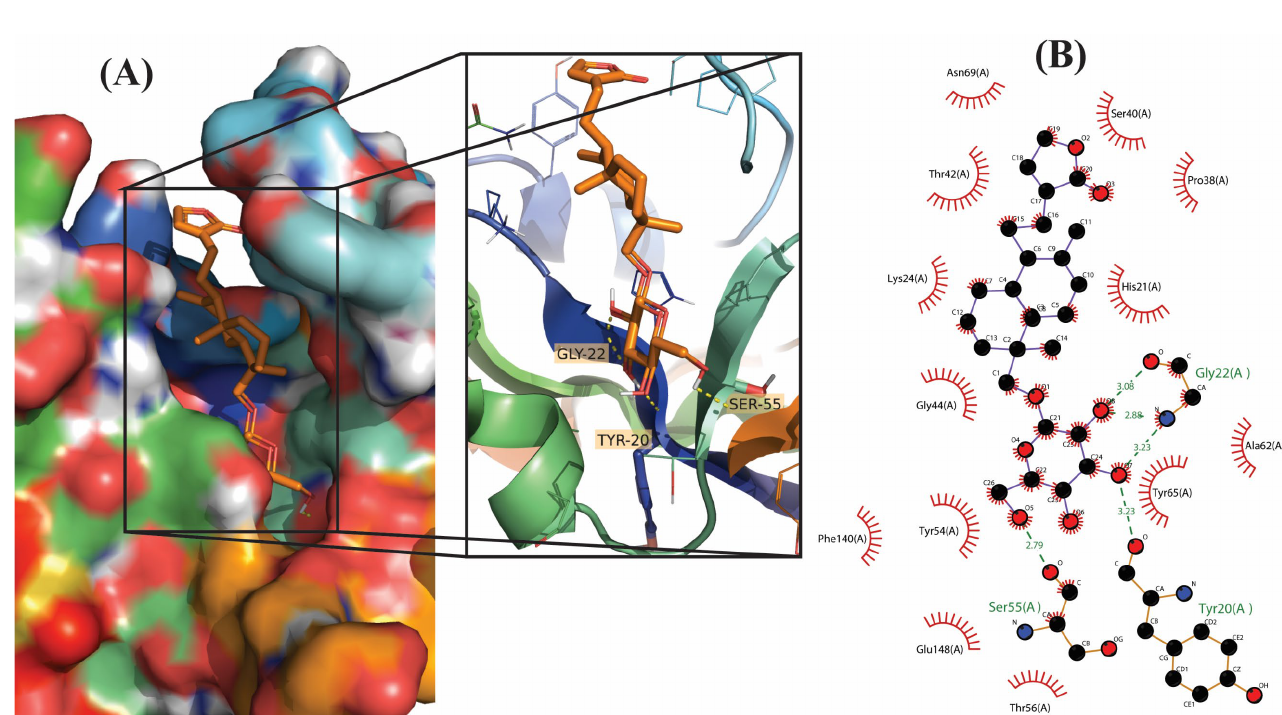
Figure 1. Molecular docking results of Neoandrographolide into the catalytic domain of diphtheria toxin. ( A ) Three-dimensional binding mode of Neoandrographolide in the protein active site. ( B ) Two-dimensional interaction showing amino acid residues involved in hydrogen, hydrophobic, and electrostatic interactions.